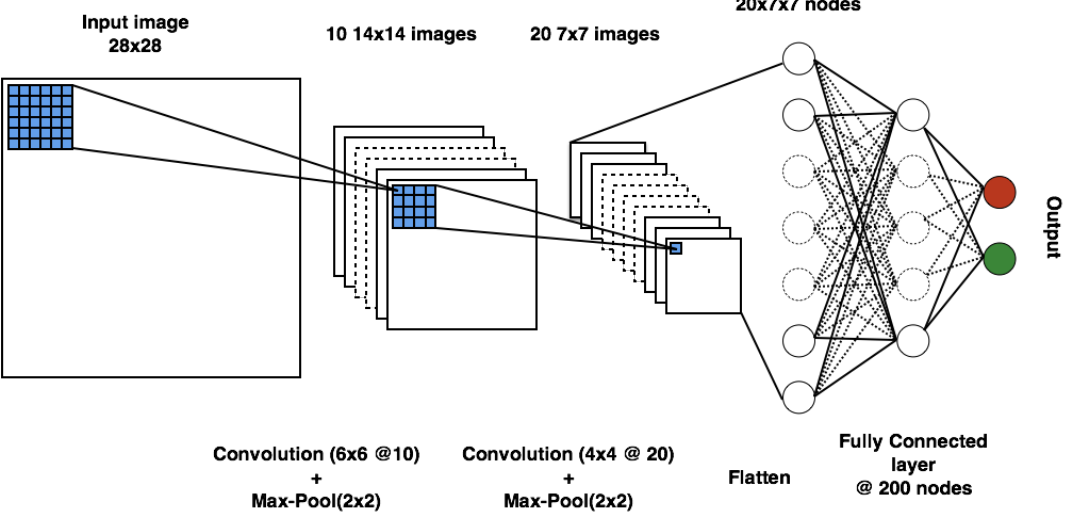
Figure 8. The CNN architecture